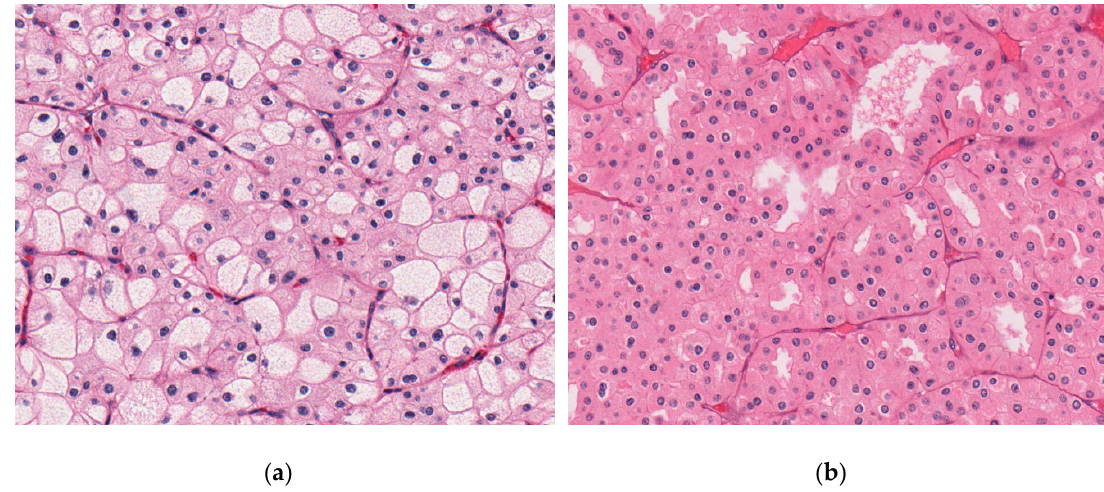
Figure 3. Representative microscopic images of chromophobe renal cell carcinomas (chRCCs) in the Cancer Genome Atlas Kidney Chromophobe (TCGA-KICH) cohort, whole-slide images from the Cancer Digital Slide Archive [21] ( a ) classic chRCC with pale cells (TCGA-KL-8345). ( b ) eosinophilic chRCC without pale cells (TCGA-KL-8326).